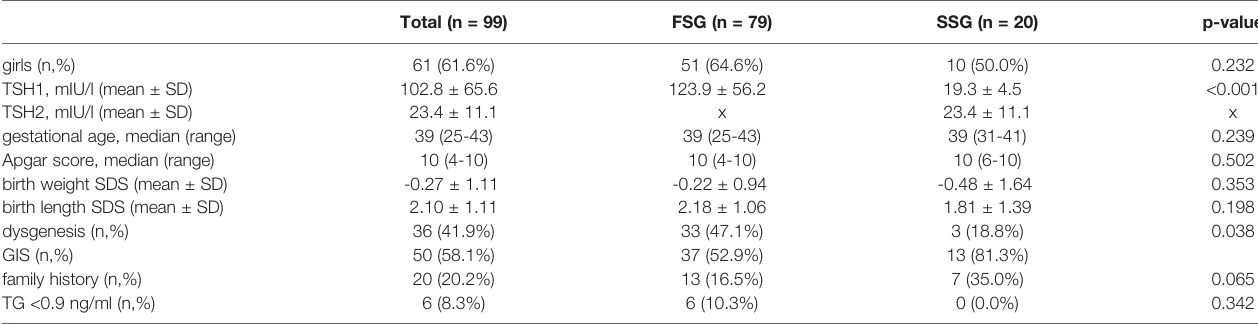
FSG, fi rst screening group; SSG, second screening group; GIS, gland in